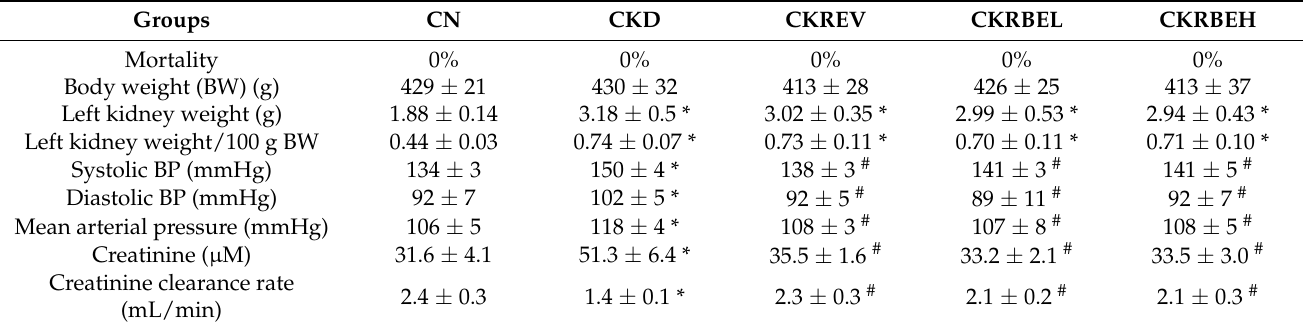
Table 2. Weight, blood pressures, and renal function.